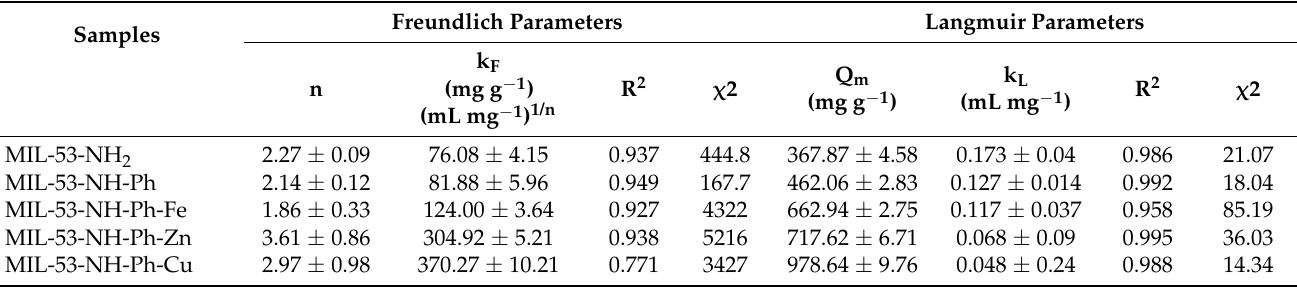
Table 3. Adsorption isotherm parameters for the uptake of carbofuran onto MIL-53-NH 2 , MIL-53-